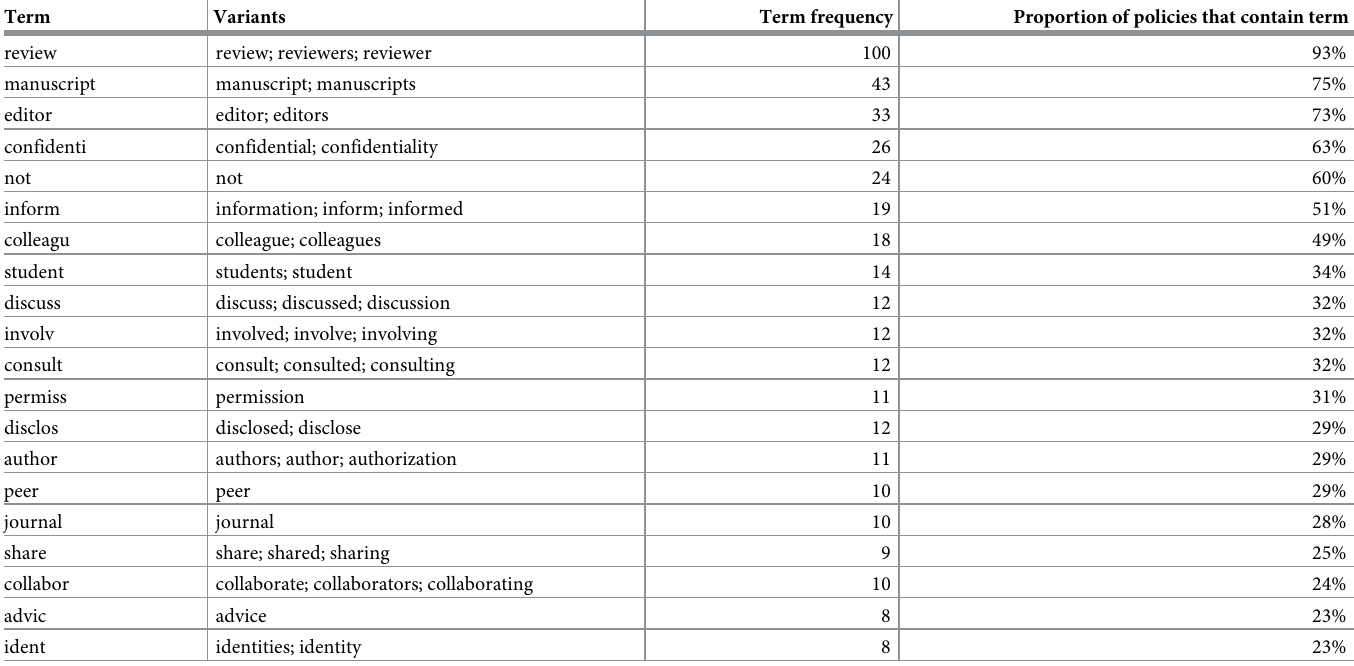
Table 1. Propensity of terms in co-review